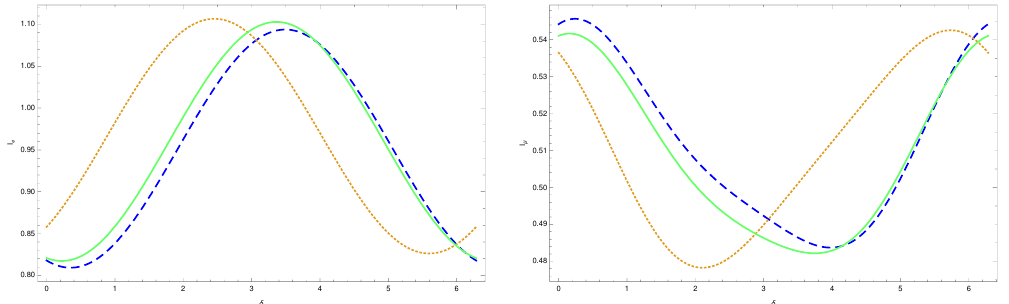
Figure 8 . I e (left panel) and I (cid:22) (right panel) for neutrinos as a function of the CP-phase for E = 400 MeV and optimal angles (cid:18) 1 ; (cid:18) 2 ; (cid:18) 3 (blue dashed, orange dotted and green solid line, respectively). Normal mass ordering is